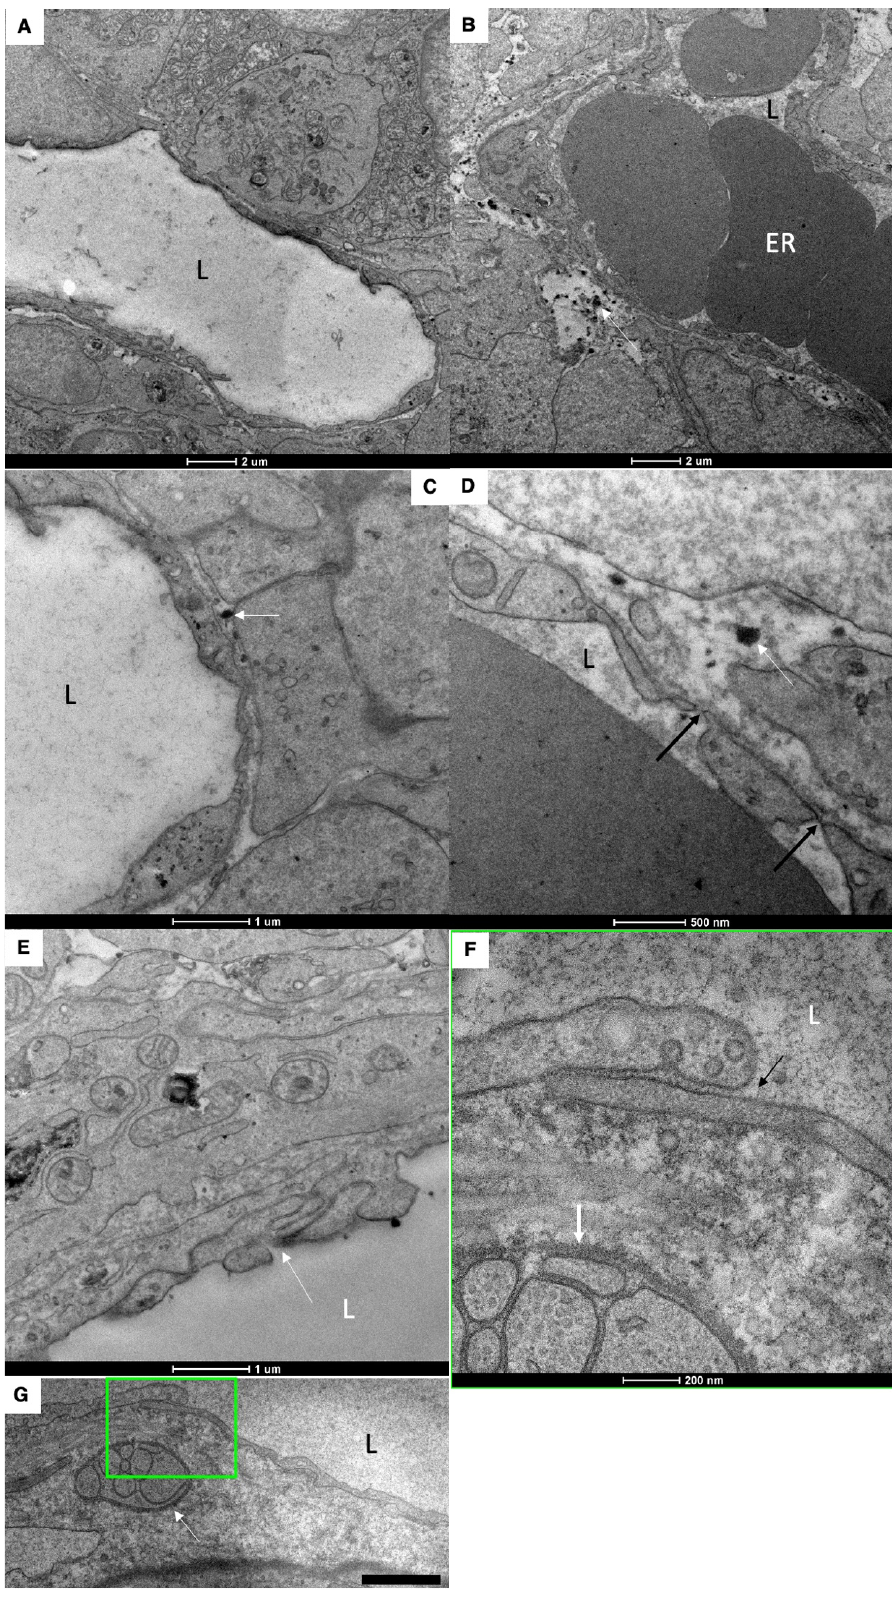
Figure 4. Structure of blood and lymph capillaries in newborn rats before their first feeding. ( A – C ) Blood capillary. Low number of fenestrae in capillary wall. ( D ) Low density of fenestrae (black arrows). White arrows in ( B – D ) show membrane remnants in the interstitial space. ( E – G ) EM